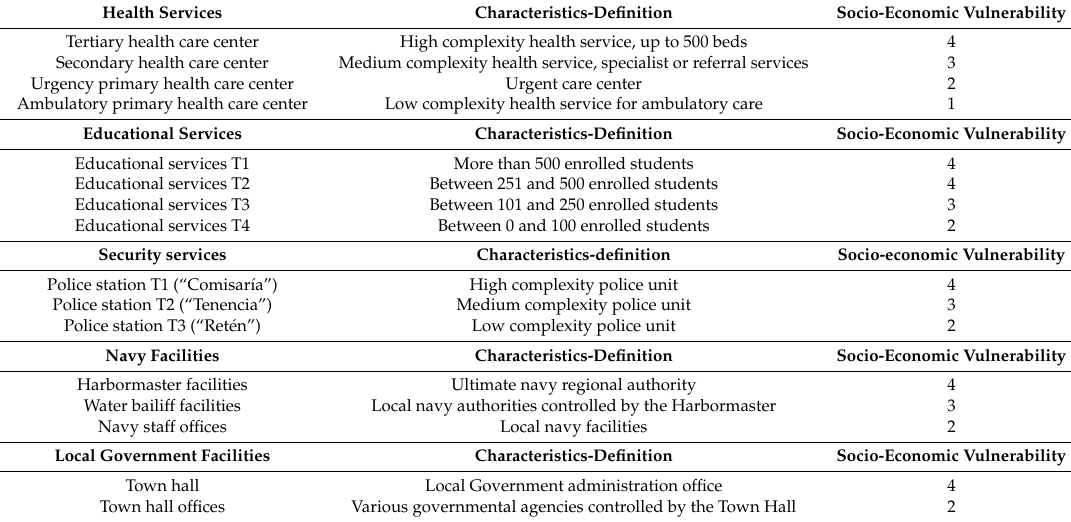
Table 4. Vulnerability of facilities, evaluated according to the type of facility and the role they have during and after catastrophic disasters (adapted from